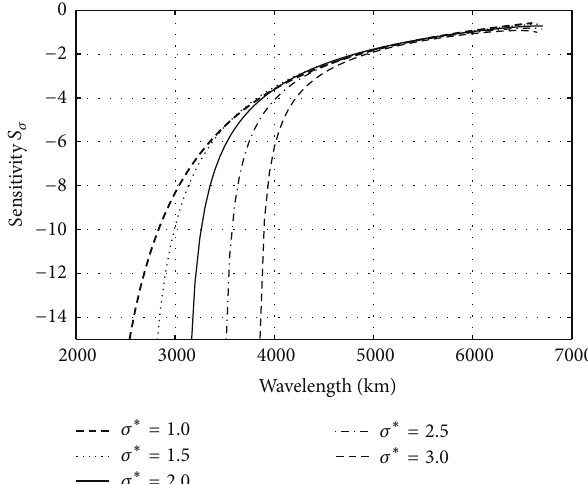
Figure 4: Sensitivity coefficients 𝑆 𝜎 versus the wavelength for different reference values of static stability parameter 𝜎 ∗ × 10 6 m 2 ⋅ Pa −2 ⋅ s −2 for the case of 𝑢 𝑇 = 7.5 m ⋅ s −1